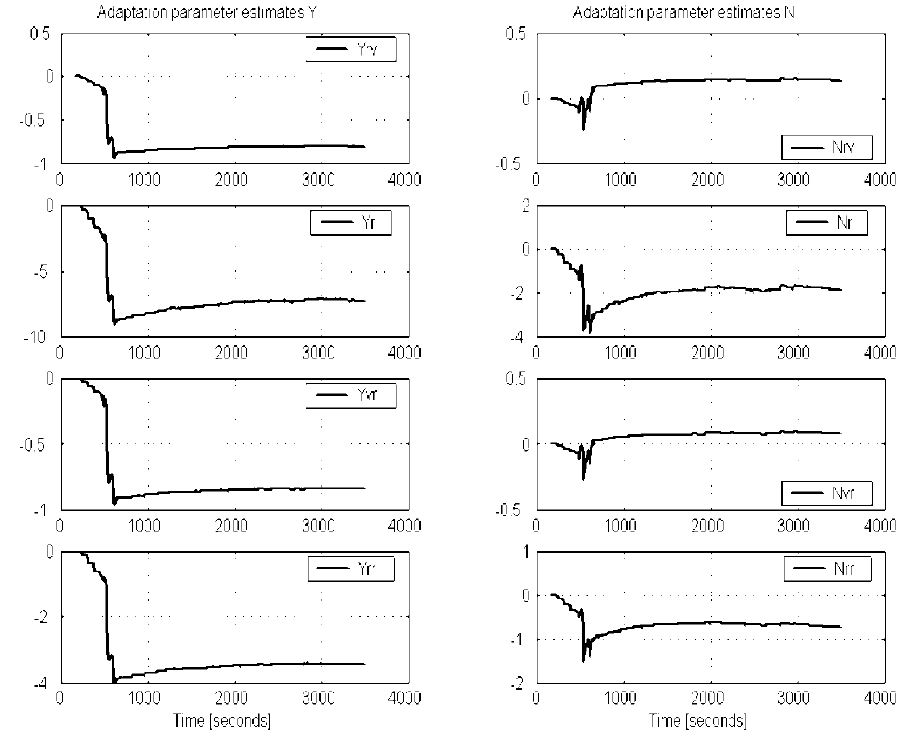
Figure 14. Adaptive parameter estimates r ˆ ( t ) in the free-running CyberShip II manoeuvering